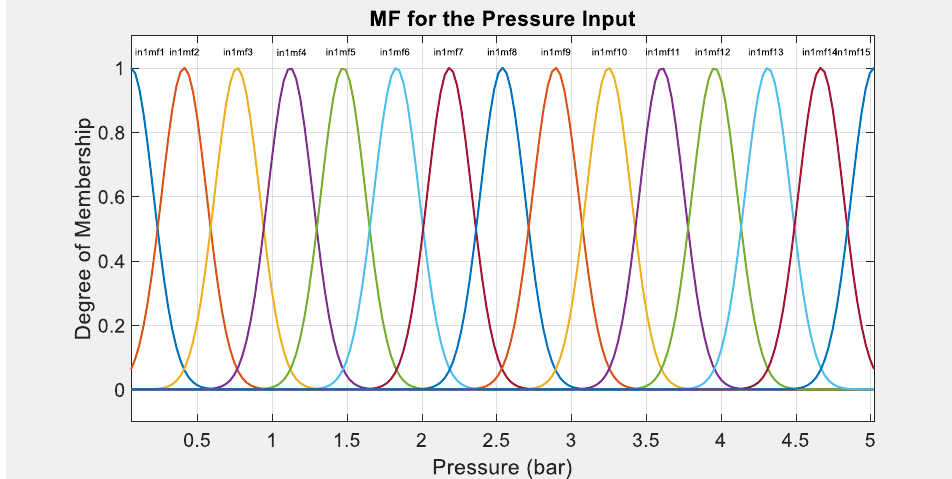
Figure 3. Membership functions of the input pressure.